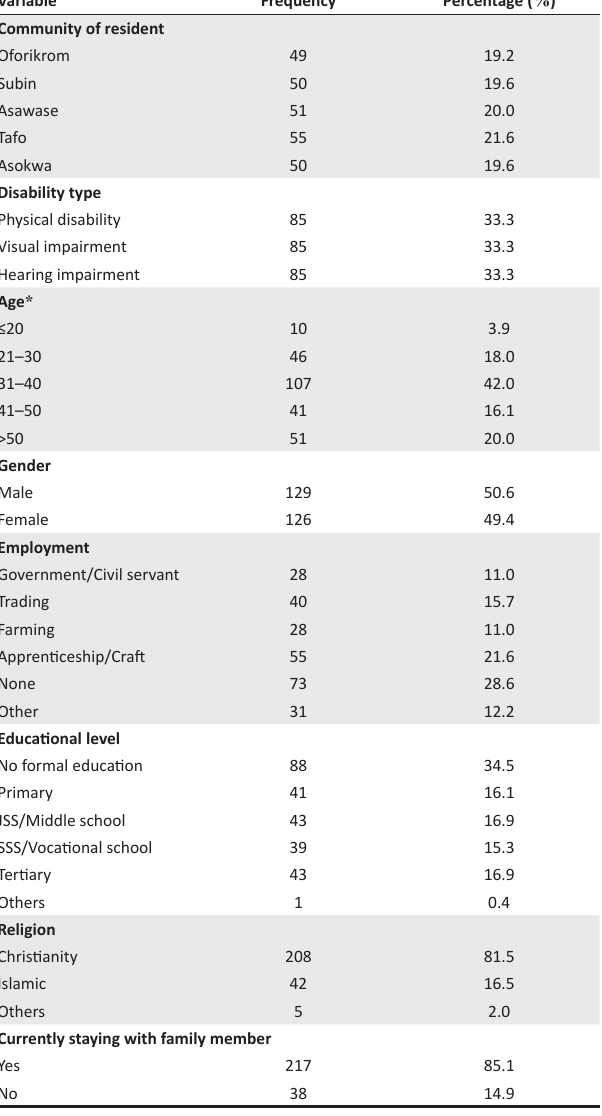
TABLE 1: Background characteristics of